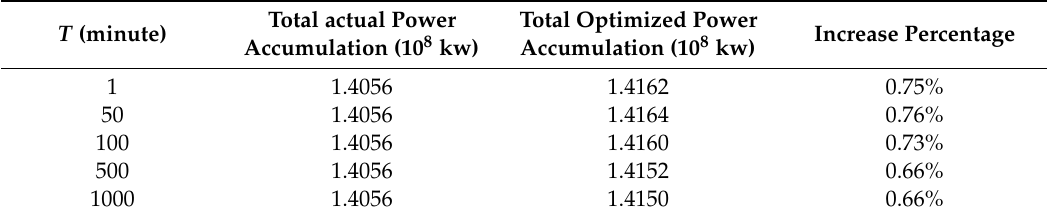
Table 8. Power optimization on #70 under di ff erent period.